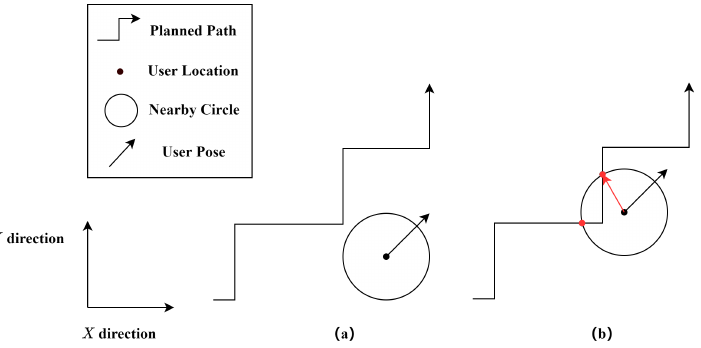
Figure 3. An illustration of the Orientation Correcting Algorithm. In situation ( a ), there is no intersection between the circle around the user and the planned path, thus an optimal path is recalculated. In situation ( b ), there is at least one intersection, and then we choose the closest intersection to the planned path’s destination as the current goal and provide the user with the corresponding